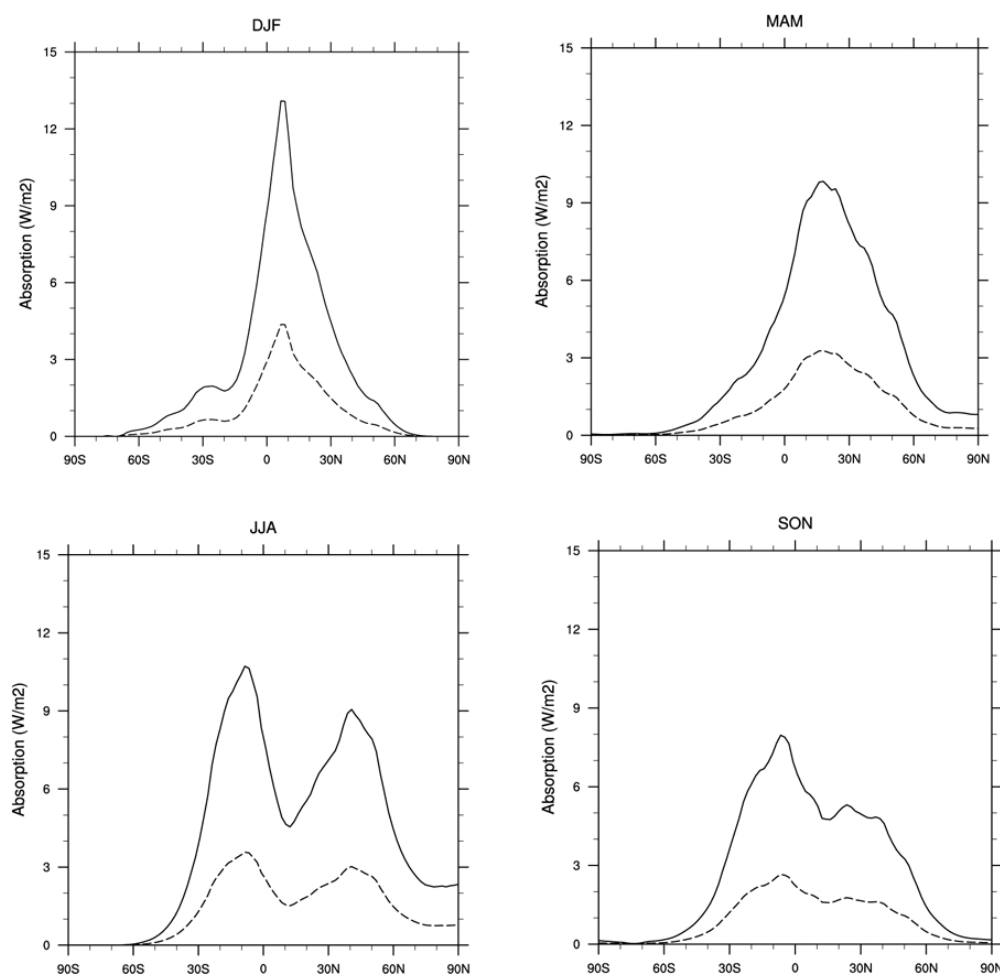
Fig. 2. Seasonal average of zonal mean shortwave atmospheric absorption (Wm − 2 ) due to carbonaceous aerosols. Solid line is for mass of carbonaceous aerosol increased by a factor of 3; the dashed line is the baseline mass in